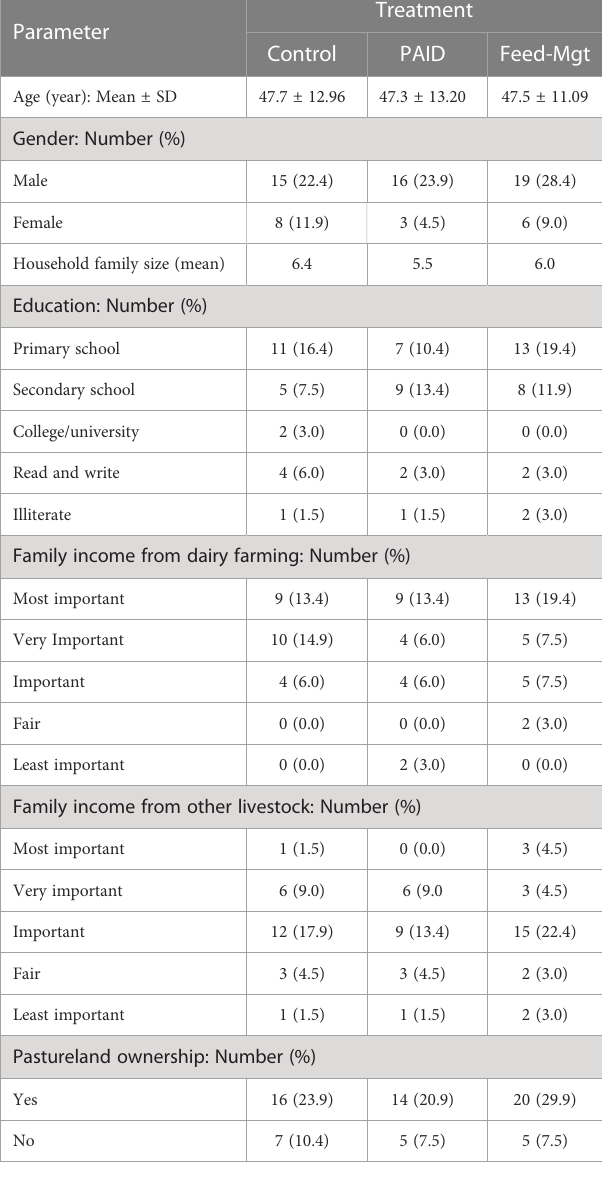
TABLE 3 Demographic and some baseline farm characteristics of the smallholder dairy